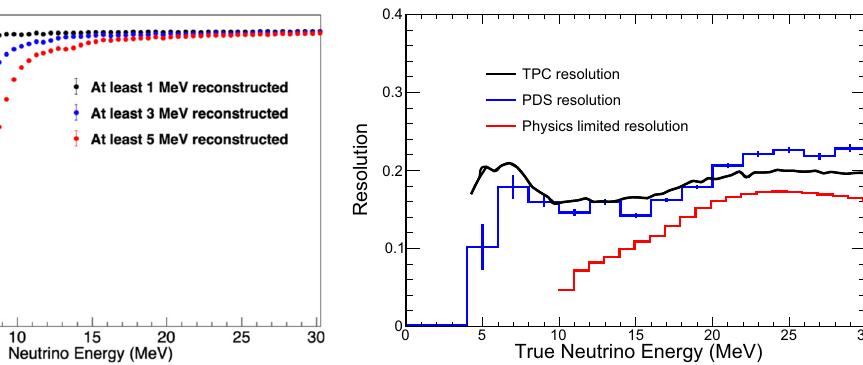
Fig. 7 Left: reconstruction efficiency as a function of neutrino energy for MARLEY ν e CC events, for different minimum required recon- structed energy. Right: fractional energy resolution (RMS of the dis- tribution of the fractional difference between reconstructed and true energy with respect to true energy) as a function of neutrino energy for TPC tracks corrected for drift attenuation (black) and photon detector